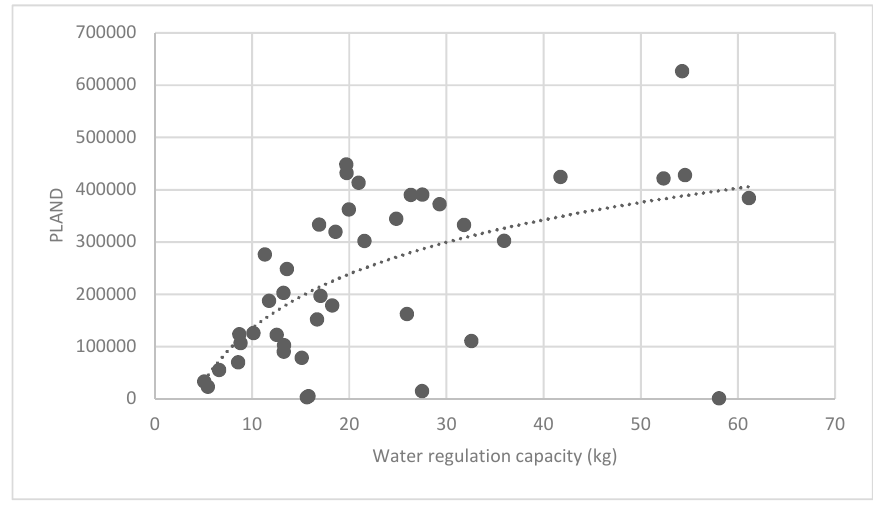
Figure 19. Association between forest land PLAND index and water regulation capacity.